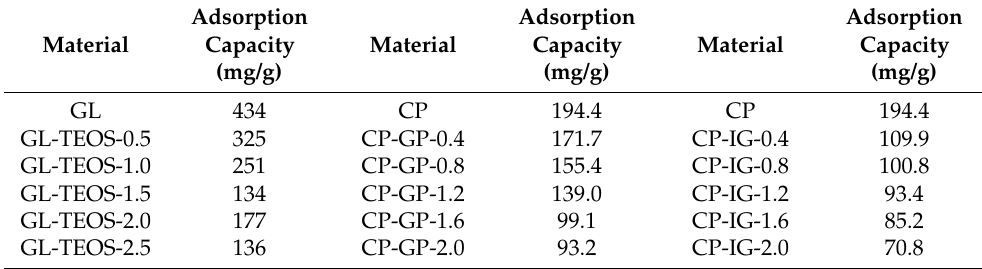
Table 3. The maximum adsorption capacity of the sample of GL and GL-TEOS-x (x = 0.5, 1, 1.5, 2, and 2.5); CP; CP-GP-x (x = 0.4, 0.8, 1.2, 1.6, and 2.0); and IP-CP-x (x = 0.4, 0.8, 1.2, 1.6, and 2.0) to